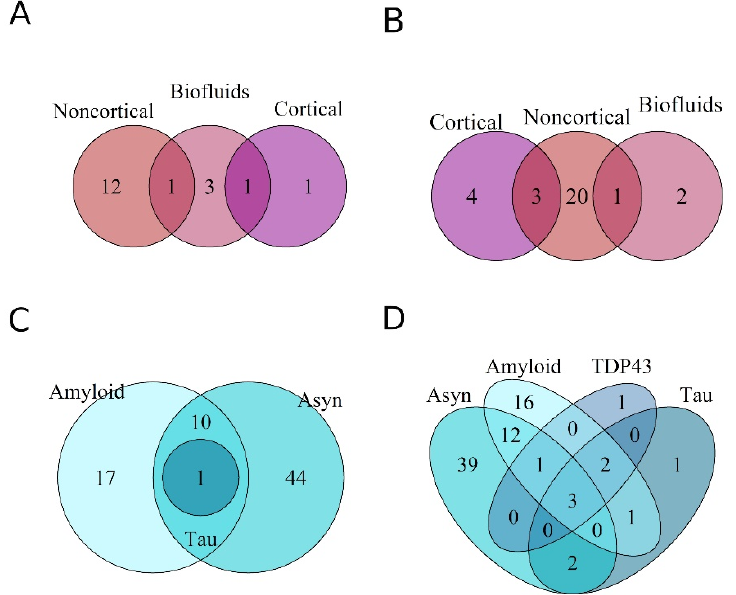
Figure 5. Venn diagrams representing miRNAs consistently differentially expressed post RRA analy- ses. The overlap between miRNAs from brain tissue and biofluids: upregulated ( A ), downregulated ( B ). Overlap of DE miRNAs between proteinopathies: upregulated ( C ), downregulated ( D ). Thereafter, the RRA method was used for miRNAs grouped together on the basis of